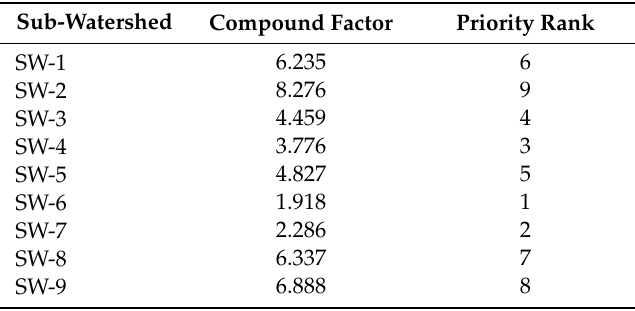
Table 12. Final priority rank of nine sub-watersheds based on CF value.